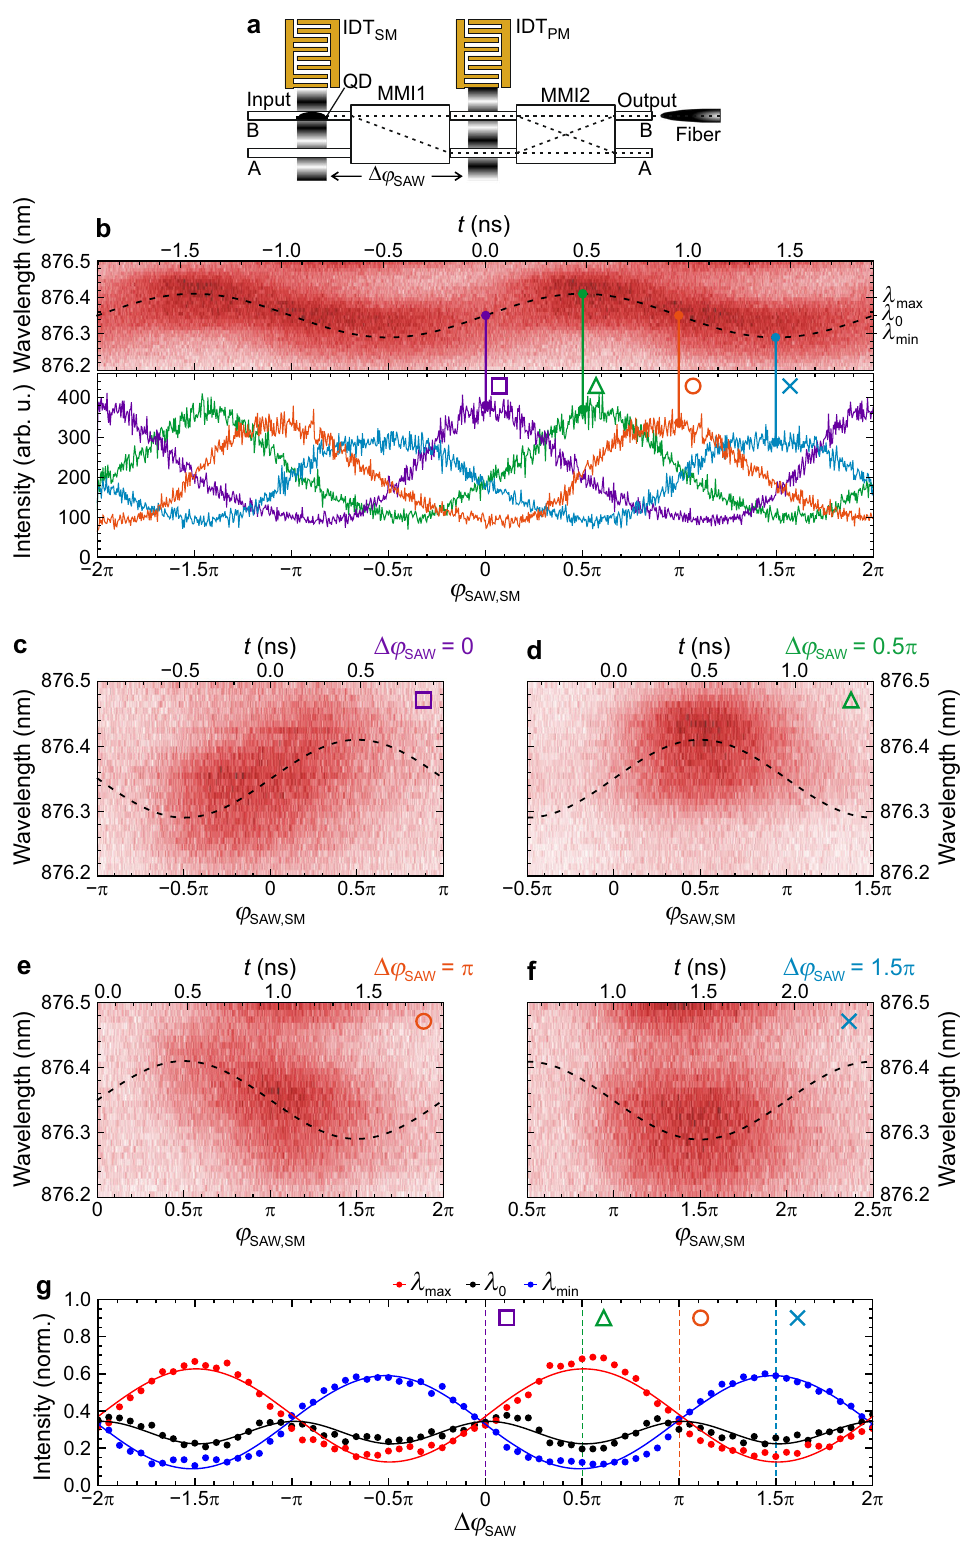
Fig. 4 | Single photon (de)multiplexing. a Schematic representation of the experimental con fi guration: Both IDTs are active. The optical transition of a single QD in Input WG-B is modulated by IDT SM while the response of the MZI is modu- latedbyIDT PM asphotonspassthrough. b Upperpanel:Acousticphase-dependent spectralmodulationoftheQD.Lowerpanel:intensitymodulationsatOutputWG-B